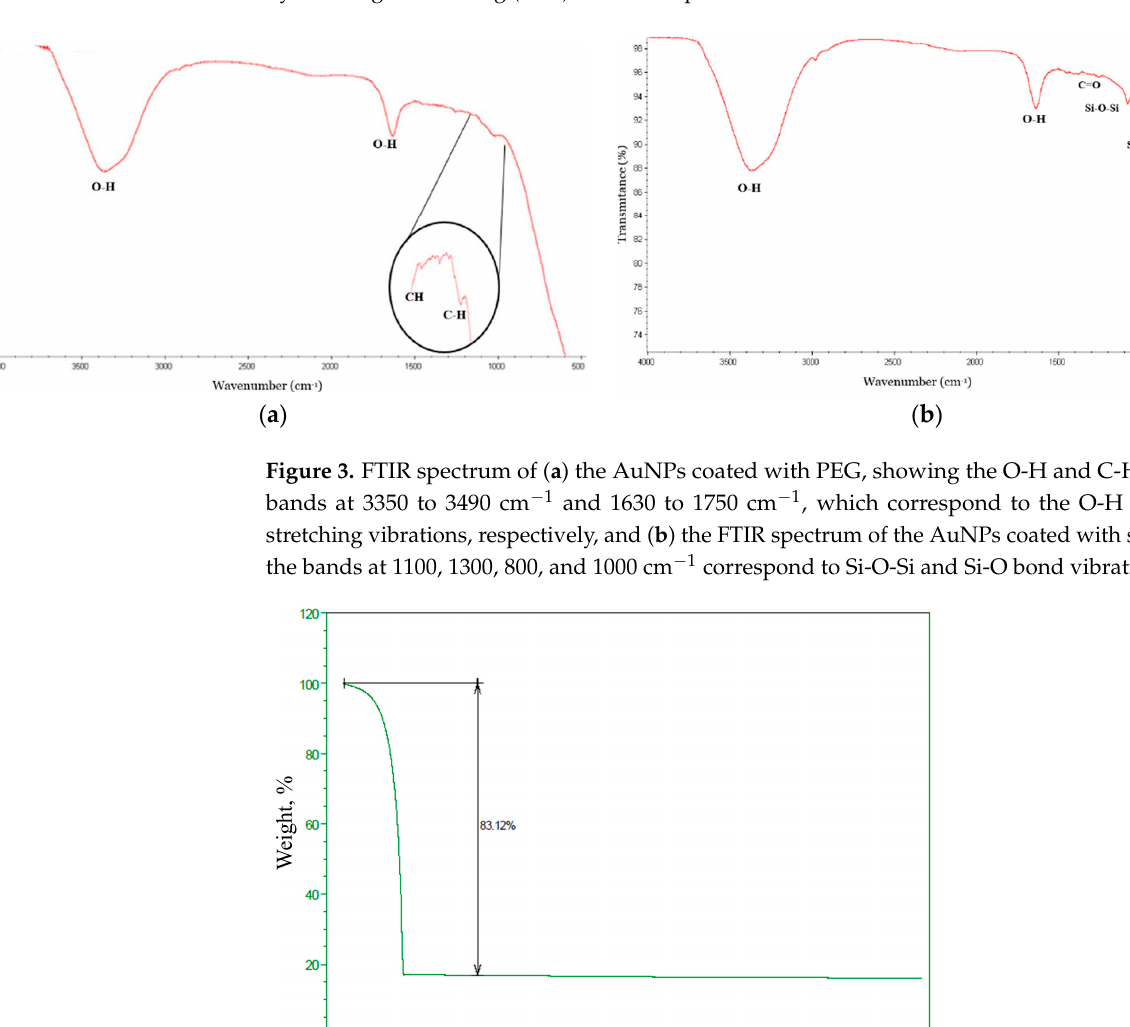
of the gold nanoparticles (AuNPs). The FTIR spectrum of the AuNPs–PEG sample showed bands between 3350, 3490, 1630, and 1750 cm − 1 , corresponding to the O-H flexion and stretching bonds, respectively. Additional bands were also observed due to the function- alization of the AuNPs with PEG, including C-H stretching bonds between 1180 and 1210 cm − 1 and C-H flexion bonds between 950 and 1050 cm − 1 . These bands indicate the success- ful coating of the AuNPs with PEG. Figure 3 shows the FTIR spectrum of the PEG-coated AuNPs. A zoom was applied to the spectrum to better visualize the bands of the PEG functional groups. FTIR was also used to determine the presence of silica on the surface of the AuNPs. The AuNPs–Silica sample showed bands between 3350 and 3490 and 1630 and 1750 cm − 1 corresponding to the O-H flexion and stretching vibrations, respectively, as well as bands between 1100, 1300, 800, and 1000 cm − 1 corresponding to the Si-O-Si vibra- tion and Si-O bond vibration, respectively. Since the samples were in suspension, we performed a thermogravimetric analysis. The thermogravimetric analysis of a sample of AuNPs was conducted to quantify the mass of the sample. The characterization of the AuNPs is shown in the resulting graph, in which the sample had an initial weight loss of 83.12%. The final weight corresponded to the presence of gold in the sample, while the rest was the medium in which the AuNPs sample was suspended. See Figure 4 for the thermogravimetric analysis of the AuNPs. The calibration curve and the results of the absorbances obtained after incubation [61] can be seen in Figure 5a and Figure 5b, respectively. (AuNPs, AuNPs–PEG, and AuNPs–silica). In the following graph, it can be seen how ibuprofen was able to adhere to the AuNPs sample; but from the first concentration, the AuNPs became saturated. It is also worth noting that from the first concentration, the drug continued to adhere to the nanostructures, which may be due to the drug anchoring to several layers on the nanostructures. On the other hand, in the AuNPs–PEG sample, there was an increase in the adhesion of the drug to the nanostructures until it reached saturation at a concentra- tion of around 100 µg/µL. Similarly, it can be seen that the drug was able to adhere to the AuNPs–silica sample, anchoring in a greater amount compared to the AuNPs sample but anchoring in a smaller amount compared to the AuNPs–PEG sample. In this sample, sat- uration was observed from a concentration of around 100 µg/µL. It was observed that all samples ceased to adsorb the drug when an initial drug concentration of around 100 was